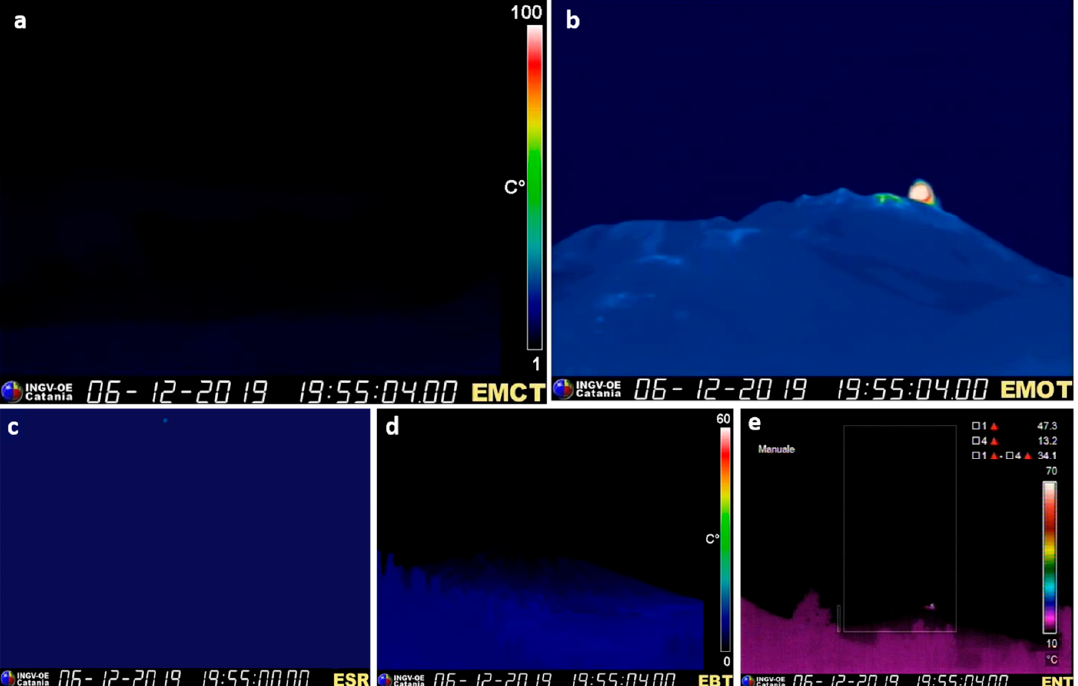
Figure 8. Raw images acquired on 6 December, 2019 at 19:55:04 UTC by EMCT ( a ), EMOT ( b ), ESR ( c ), EBT ( d ) and ENT ( e ). The ESR camera has a lower frame rate than the others, i.e., 2 fps; for this case, the ESR image closer to the other cameras is shown. The monitored scene showed the Strombolian activity started on 6 December, 2019, and was clearly visible from EMOT and ENT cameras. Table 6. Algorithm Outcomes of the DT and BoW-based classifiers for the eruptive activity at NSEC on 6 December, 2019. Thermal Camera Visibility Volcanic Activity EMOT “clear” “explosion” EMCT “clear” “no activity” ESR “fuzzy” “no activity” ENT “fuzzy” “explosion” EBT “clear” “no